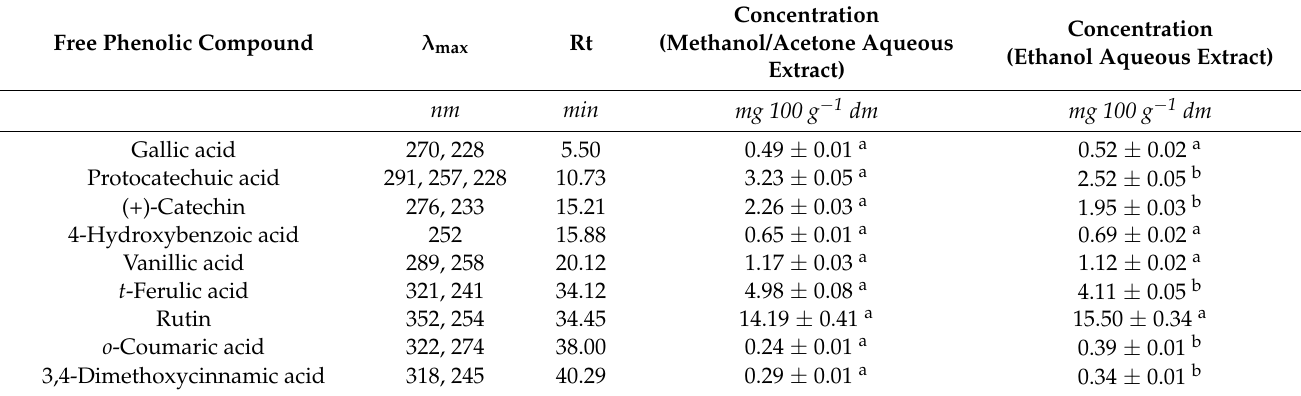
Table 5. Phenolic compounds identified and quantified in the methanol/acetone and ethanol aqueous extracts. Different letters in the same row represent statistical different results ( p <